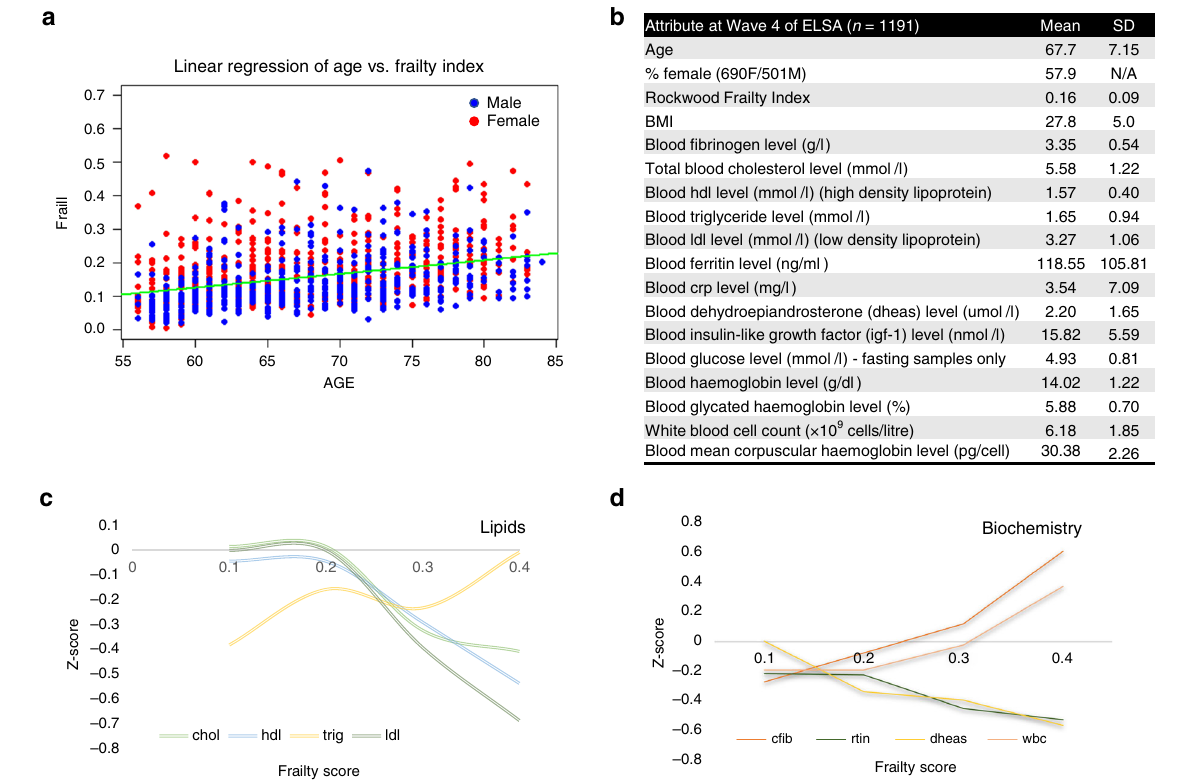
Fig. 1 Sample attributes at wave 4 of ELSA. a Linear regression of Age vs. Frailty Index score indicating a moderate correlation and implying that the concept of frailty, when measured under the Rockwood FI scoring system, is an independent variable with respect to age (blue dots = male subjects, red dots = female subjects). b Mean sample characteristics from 1191 subjects and associated blood analysis. c Mean cholesterol levels as observed across the frailty distribution using the standard scoring method. It can be seen that LDL, HDL and cholesterol all decrease when entering the non-frail cut-off 50 . Triglycerides are seen to increase. d Most pronounced biochemistry levels as observed across the frailty distribution using the standard scoring method. Fibrinogen and white blood cells indicating a marked increased Z-score over the frailty distribution whereas ferritin and dehydroepiandrosterone indicate a decrease. Source data are provided as a Source Data fi